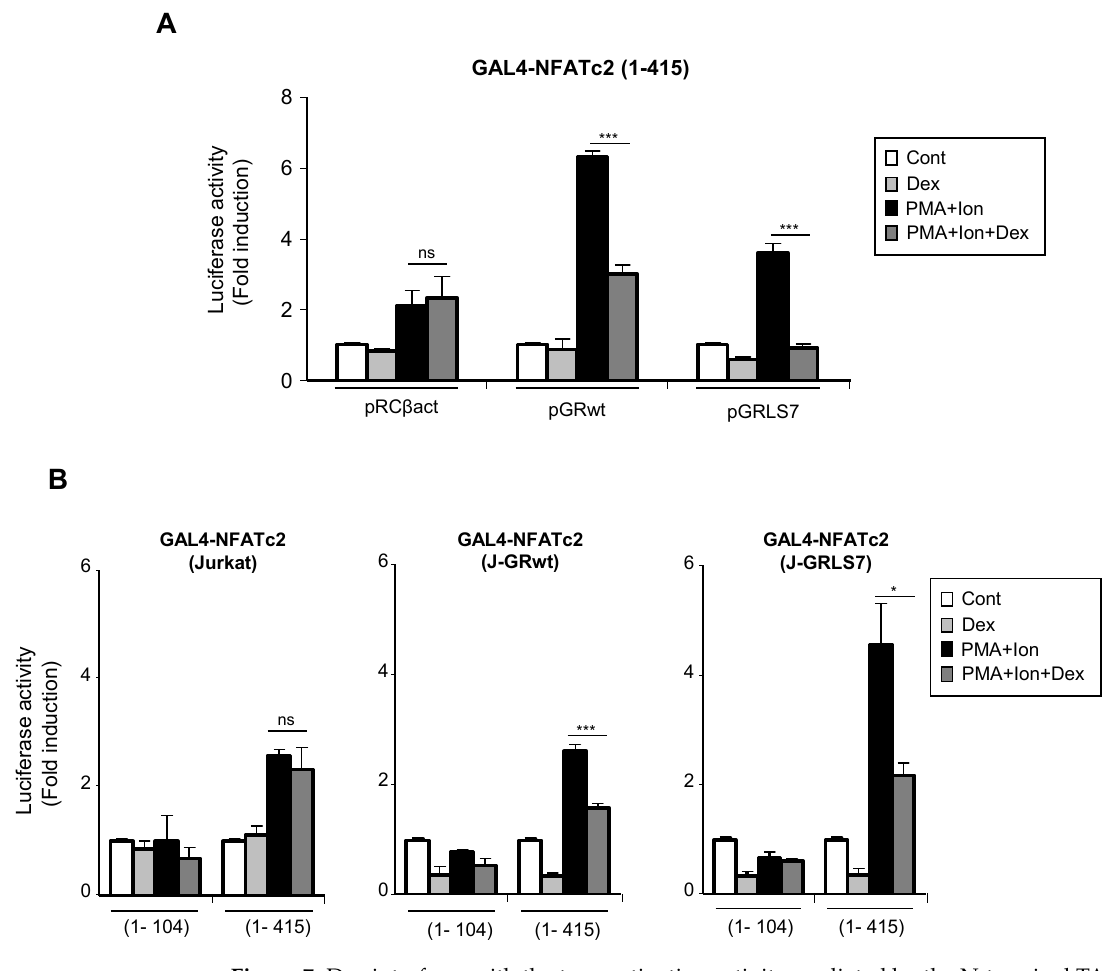
Figure 7. Dex interferes with the transactivating activity mediated by the N-terminal TAD of NFAT. ( A ) Jurkat cells were co-transfected with a pGAL4-Luc reporter plasmid and the GAL4-NFATc2 (1–415) expression vector containing the N-terminal TAD of NFATc2, along with empty plasmid (pRC β act) or expression vectors for GR constructs wt or LS7 mutant. ( B ) Parental, J-GRwt, and J-GRLS7 Jurkat cells were transiently transfected with the pGAL4-Luc reporter plasmid and the GAL4-NFATc2 constructs expressing amino acids 1–104 or 1–415 of the N-terminal TAD of NFATc2. Transfected cells were pre-treated or not with Dex (1 μ M) before stimulation with PMA + Ion (15 ng/mL + 1 μ M) for 18 h. Luciferase activity is represented as fold induction (PMA + Ion over unstimulated control samples) (mean ± SEM). ns: non-significant; * p < 0.05; *** p < 0.001; PMA + Ion +Dex vs. PMA + Ion treatment). Results shown are from a representative of three independent ex- periments performed in triplicate.